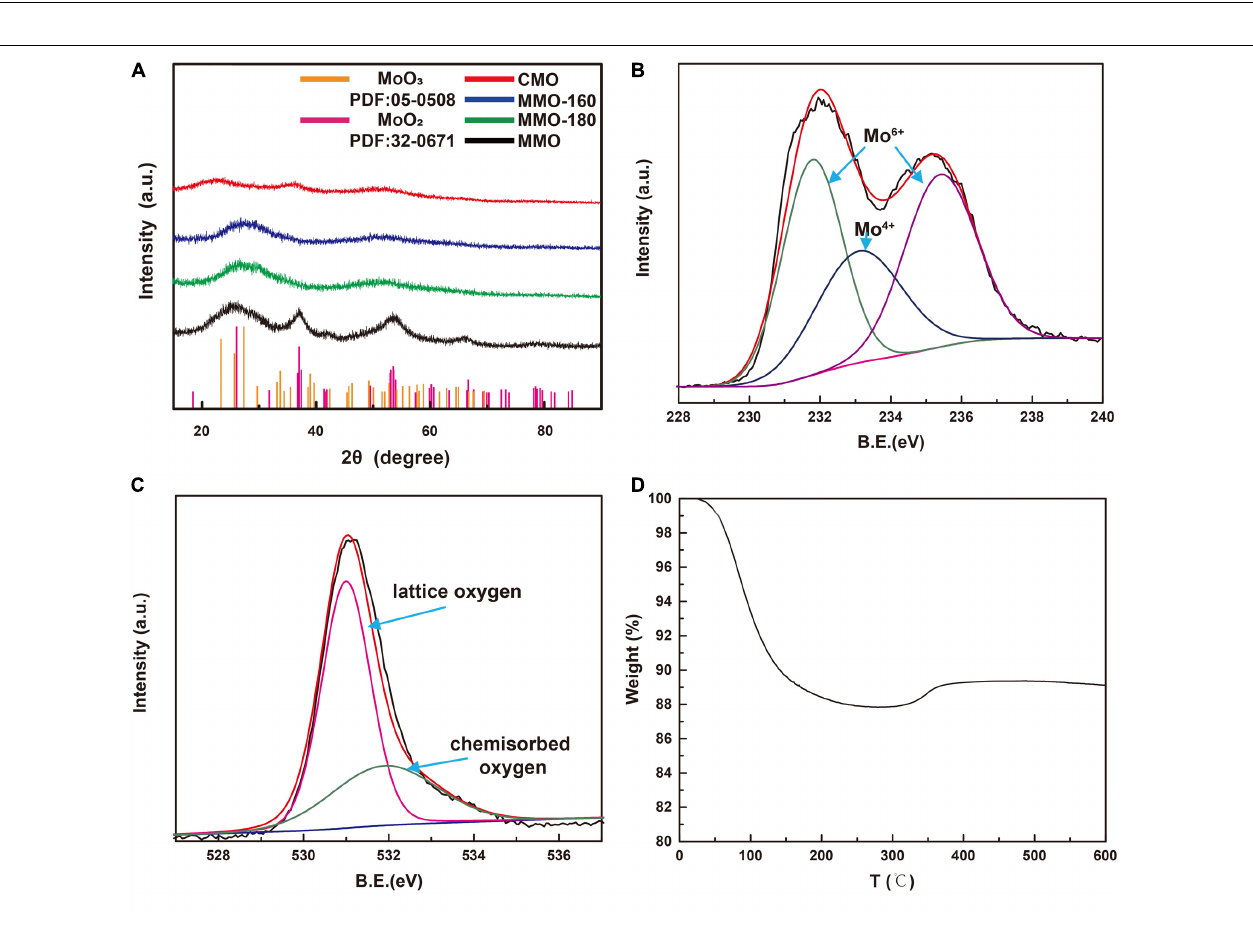
FIGURE 2 | (A) XRD patterns of MMO, MMO-180, MMO-160, and CMO; XPS spectra of (B) Mo 3d and (C) O1s, and (D) TGA curves of